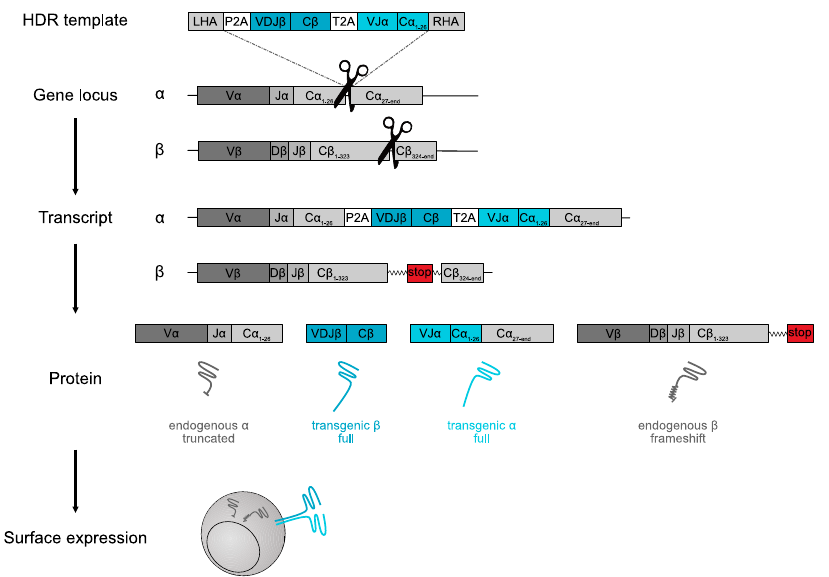
Figure 2. Schematic of orthotopic TCR replacement through clustered regularly interspaced short palindromic repeats (CRISPR) / CRISPR-associated protein 9 (Cas9)-mediated gene editing. The shown homology-directed repair (HDR) template is designed in a manner that the complete αβ TCR is integrated into the endogenous T-cell receptor alpha constant ( TRAC ) gene locus upon a CRISPR / Cas9-mediated double-strand break. Simultaneously, T-cell receptor beta constant ( TRBC ) is edited, and non-homologous end joining leads to knock-out of the endogenous TCR β -chain. Cleavage of 2A elements leads to intracellular expression of transgenic TCR chains and a truncated endogenous TCR α -chain; thus, at the surface, only the transgenic αβ TCR is expressed. LHA, left homology arm. RHA, right homology arm. P2A, T2A, self-cleaving peptides. VJ / VDJ, variable parts of TCR. C α , TRAC. C β , TRBC. For more information, see References [26,31].